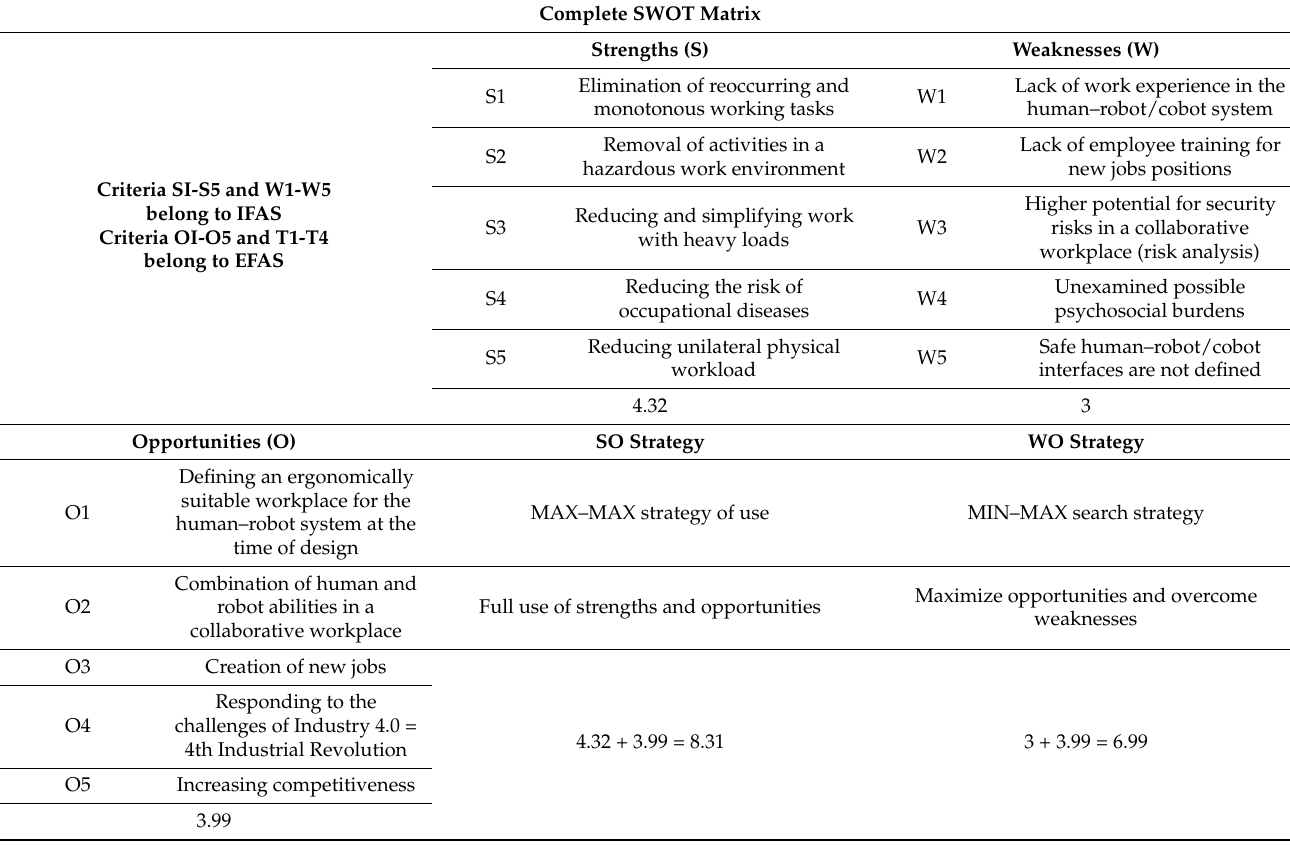
Table 7. Complete SWOT matrix with discrete criteria; Source: Own elaboration. Complete SWOT